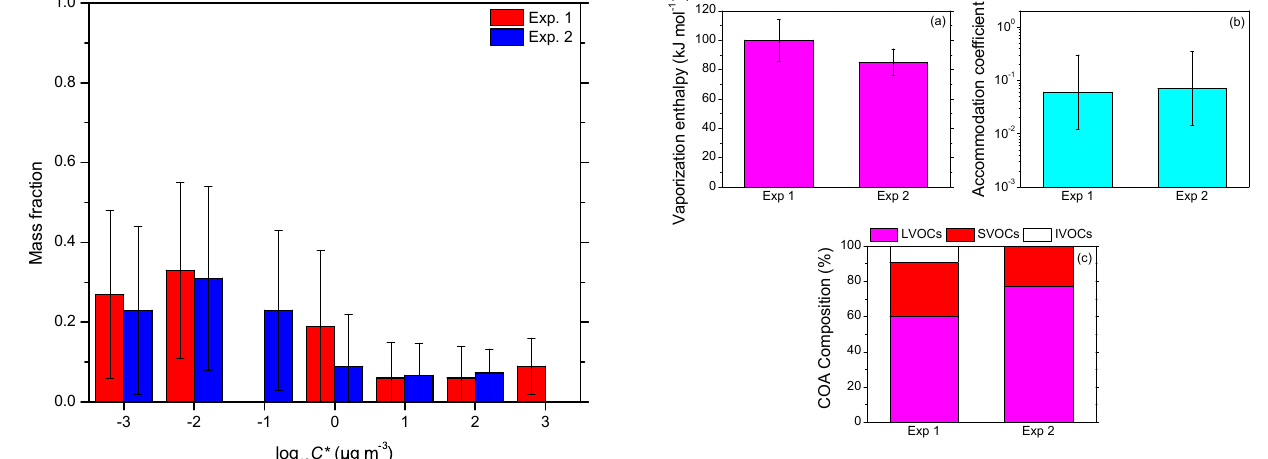
Figure 3. (a) Estimated effective vaporization enthalpies along with their uncertainties for both experiments using the approach of Karnezi et al. (2014). (b) Estimated effective accommodation coef- ficients along with their uncertainties for both experiments. (c) COA mass composition of both experiments. LVOCs are represented in magenta, SVOCs in red, and IVOCs in